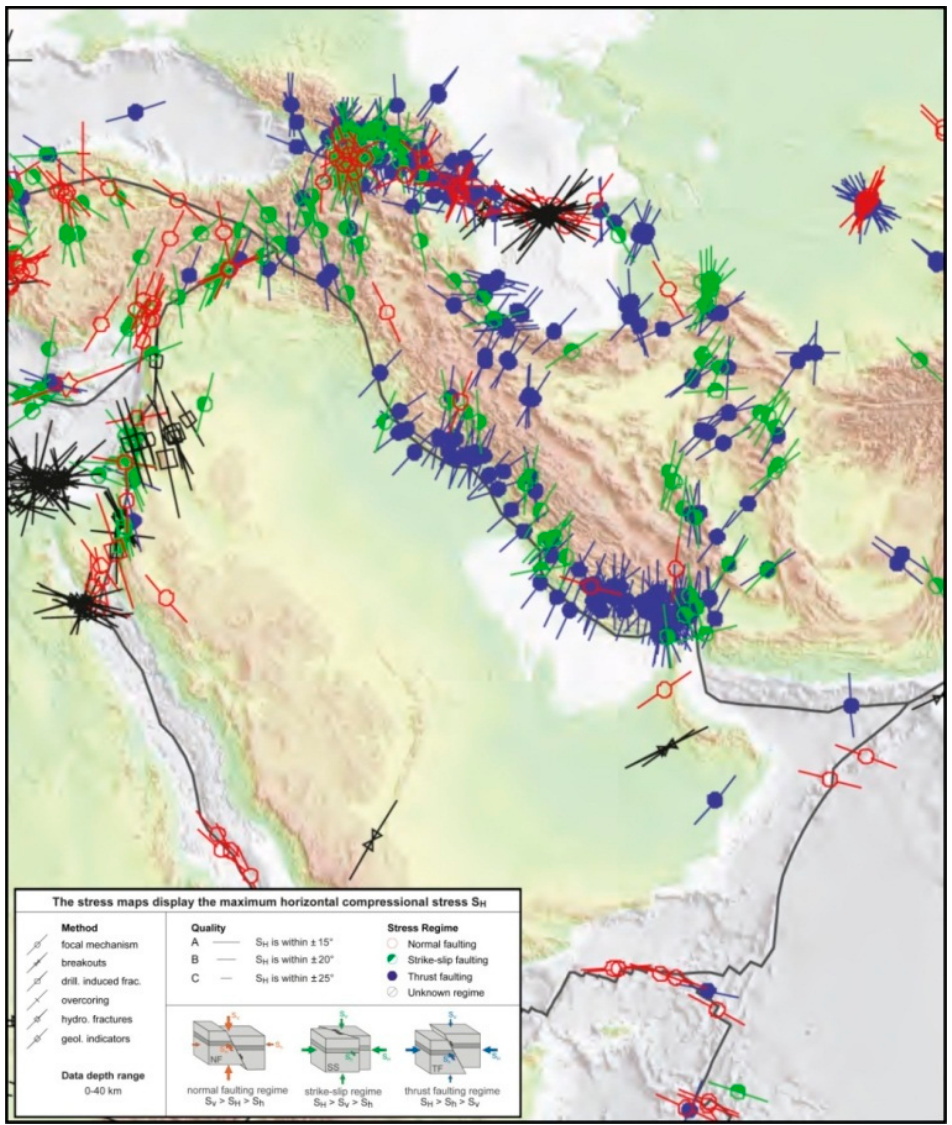
Figure 15. World Stress Map generated for the study area to infer the orientation of the in situ stress field (Courtesy of the World Stress Map Project) [53]. field (Courtesy of the World Stress Map Project)